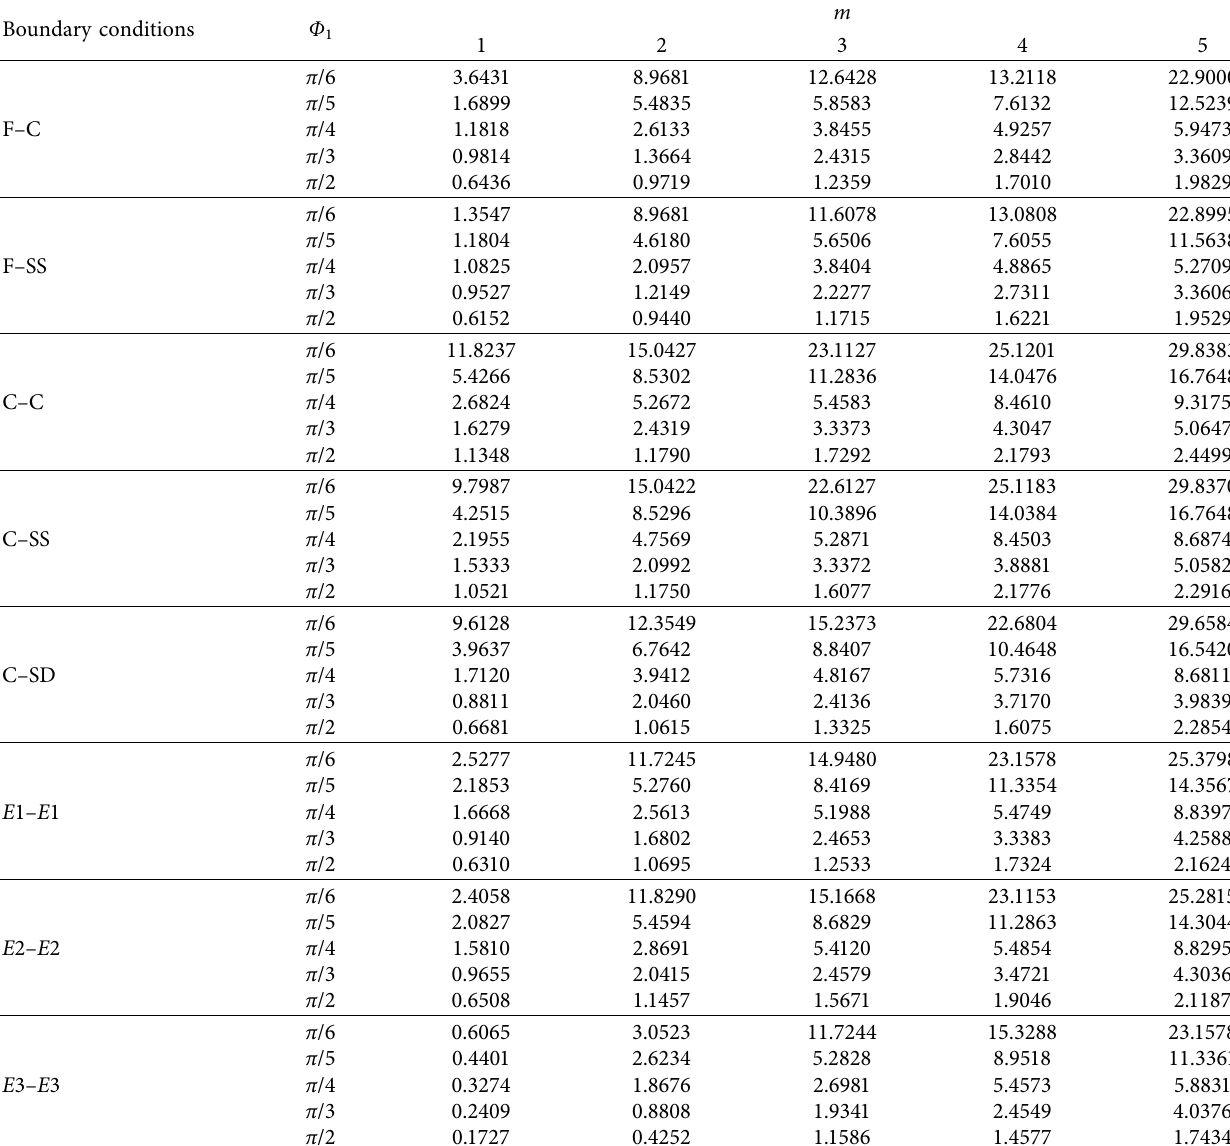
� π /8, R � 1m, h � 0.06m, and n � 1). 1 ( φ 0